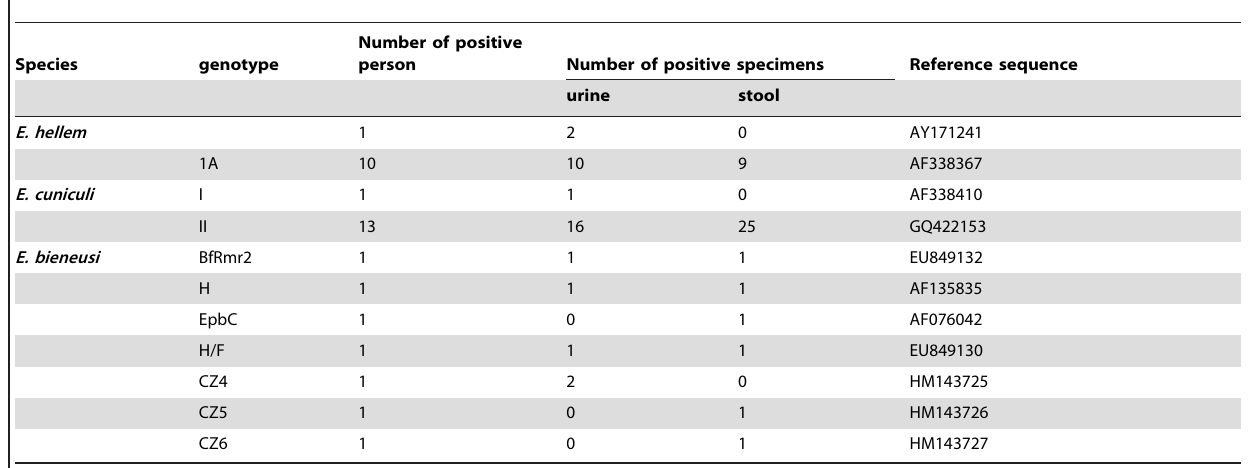
Table 2. Detection of microsporidia in urine and stool samples of naturally infected immunocompetent